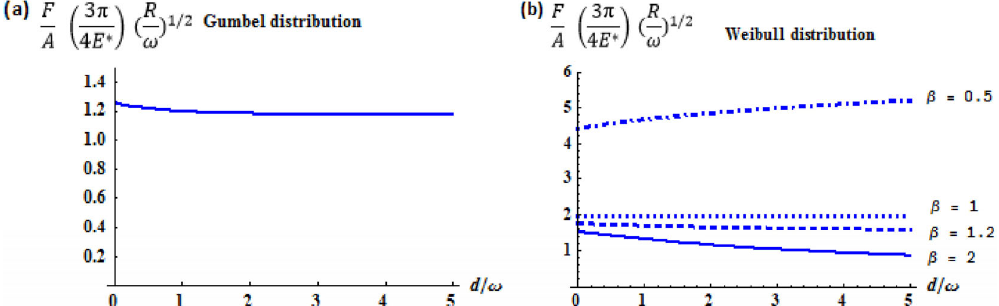
Fig. 4 Different Weibull and Gumbel distributions as summits distribution with Hertzian contact. (a) Gumbel distribution gives an almost flat pressure which indicates the validity of Amontons’ law for the range of ( ω , 5 ω ). (b) The Weibull distributions have different trends for various values of beta. β = 1 corresponds to the exponential distribution which shows exact proportionality between the load and the area of contact independent of the surface model. There is also good correspondence with Amontons Law values of beta near one (Fig.